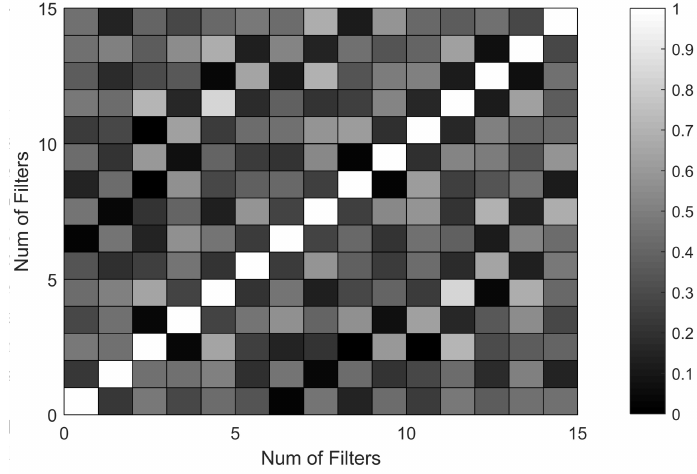
Figure 7. Correlation coefficients of learned filters in